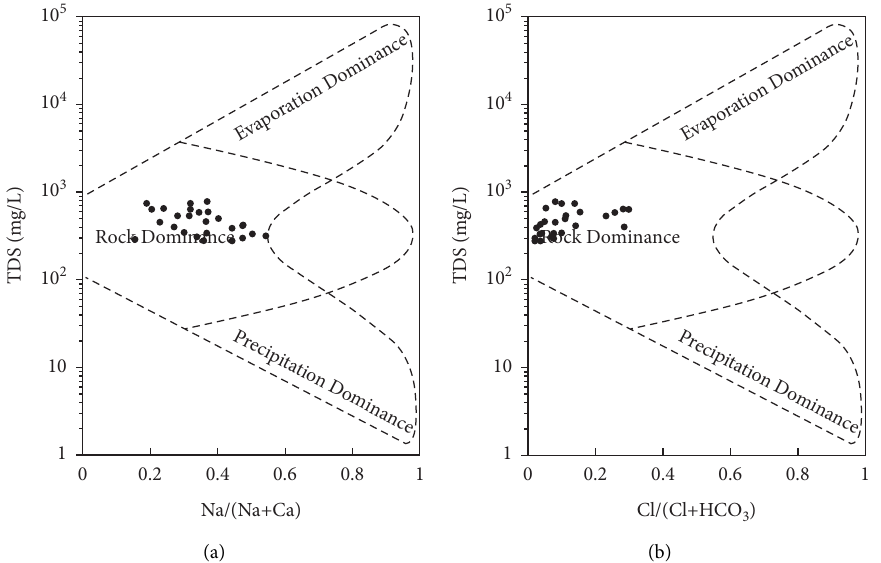
Figure 4: Gibbs diagram of the shallow